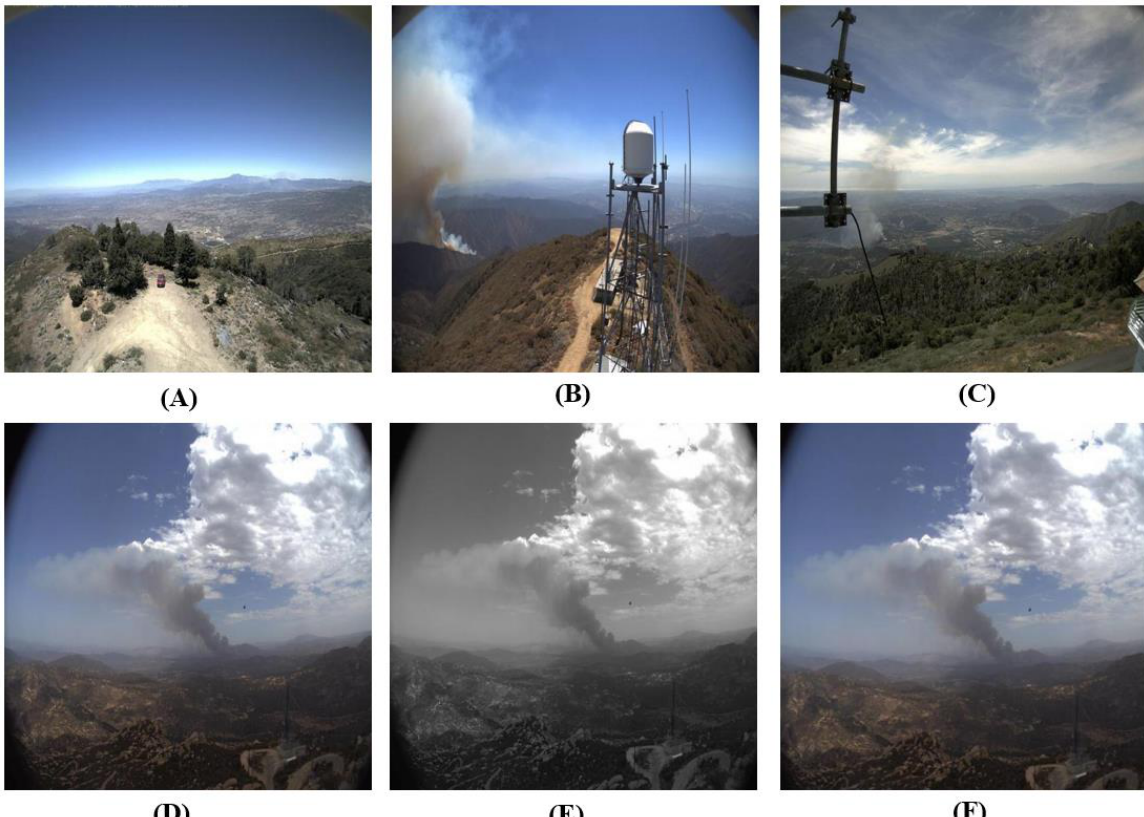
Figure 3. Wildfire smoke-detection samples of dataset. ( A ) Shows a far detection area. ( B ) Shows a close detection area. ( C ) Shows a medium detection area. ( D ) Shows another sample before data augmentation. ( E ) Shows grayscale of 50%. ( F ) Shows cropped sample of 10% maximum zoom. Table 2. Description of dataset following data-augmentation techniques.